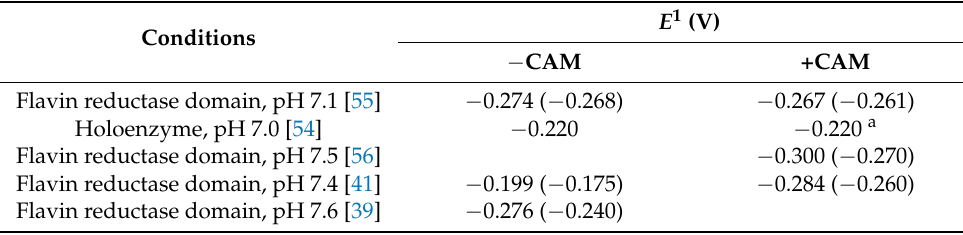
Table A1. Redox potentials of FMNH/FMNH 2 couple ( E 1 ) of nNOS. Their values, adjusted to pH 7.0 assuming that the reduced FMN is doubly protonated [54], are given in parentheses. E 1 (V) Conditions − CAM +CAM Flavin reductase domain, pH 7.1 [55] − 0.274 ( − 0.268) − 0.267 ( − 0.261)